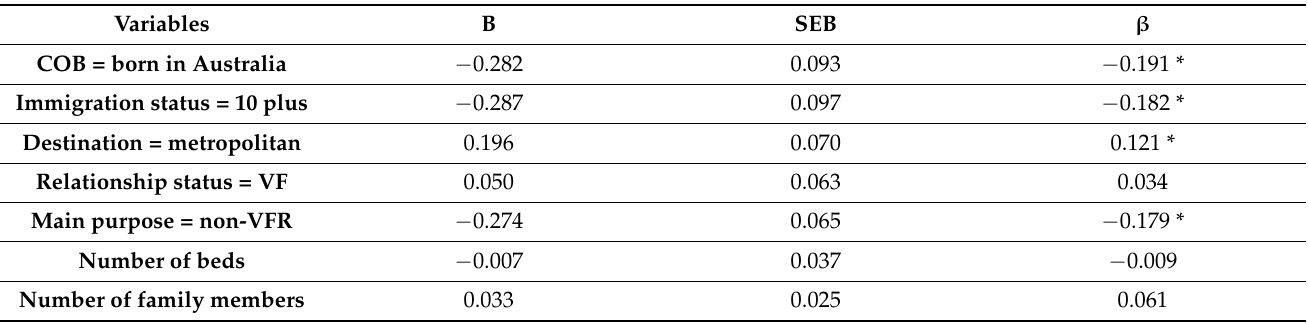
Table 7. Regression analysis summary of the host’s variables predicting the total expenses of hosting travel